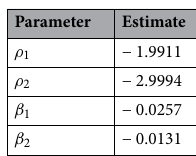
Table 4. Results from fitted VECM. The estimates for all parameters are normalized.